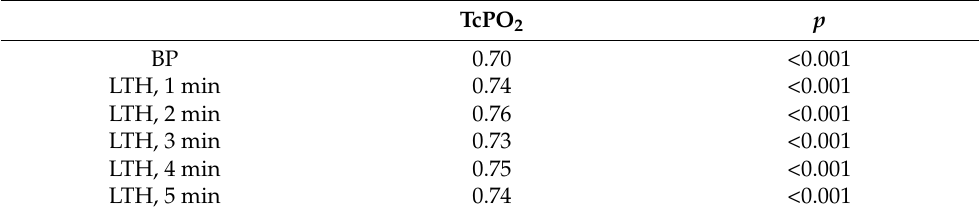
Table 2. Correlation between the parameters of the IOFF signal and value of the TcPO 2 assessed on 54 measurements (27 patients). The table shows the correlation